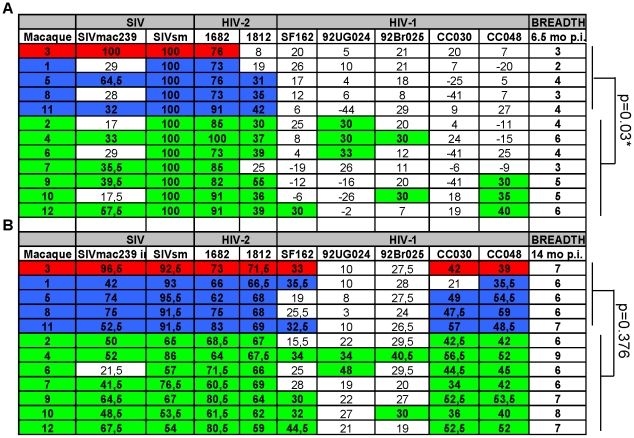
Evolution of neutralization breadth over time.Comparison of neutralization breadth at 6.5 (A) and 14 (B) months post-inoculation. Color code: NC, red, TC, blue, LC, green Figure denotes % neutralization at 1∶20 dilution. SIVsm used was SMM-3. The LC macaques displayed a significantly greater breadth at 6.5 months compared with the NC/TC group (p = 0.03, Mann-Whitney test).